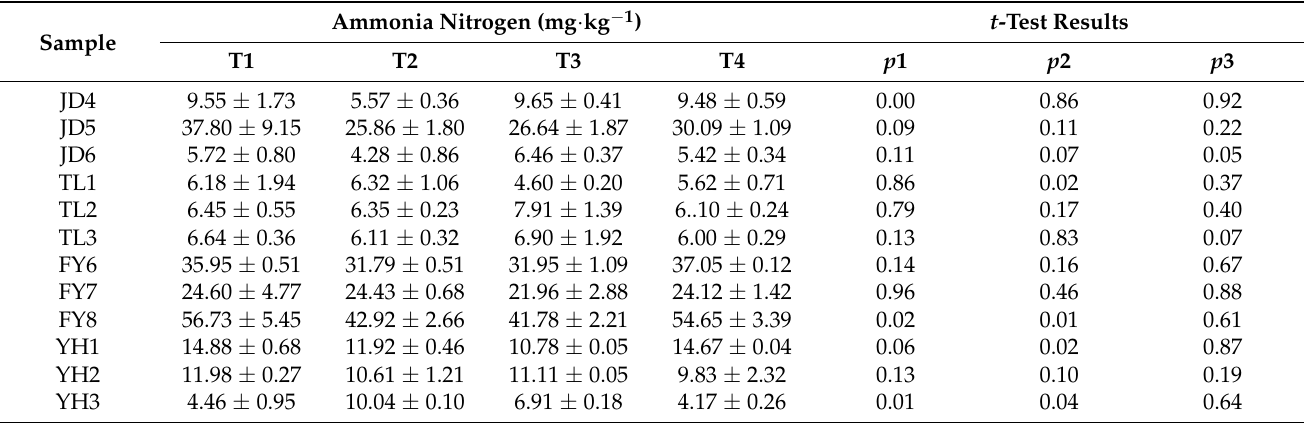
Table 5. Comparison between determination results of Kit Method and Indophenol Blue Colorimetry ( n =